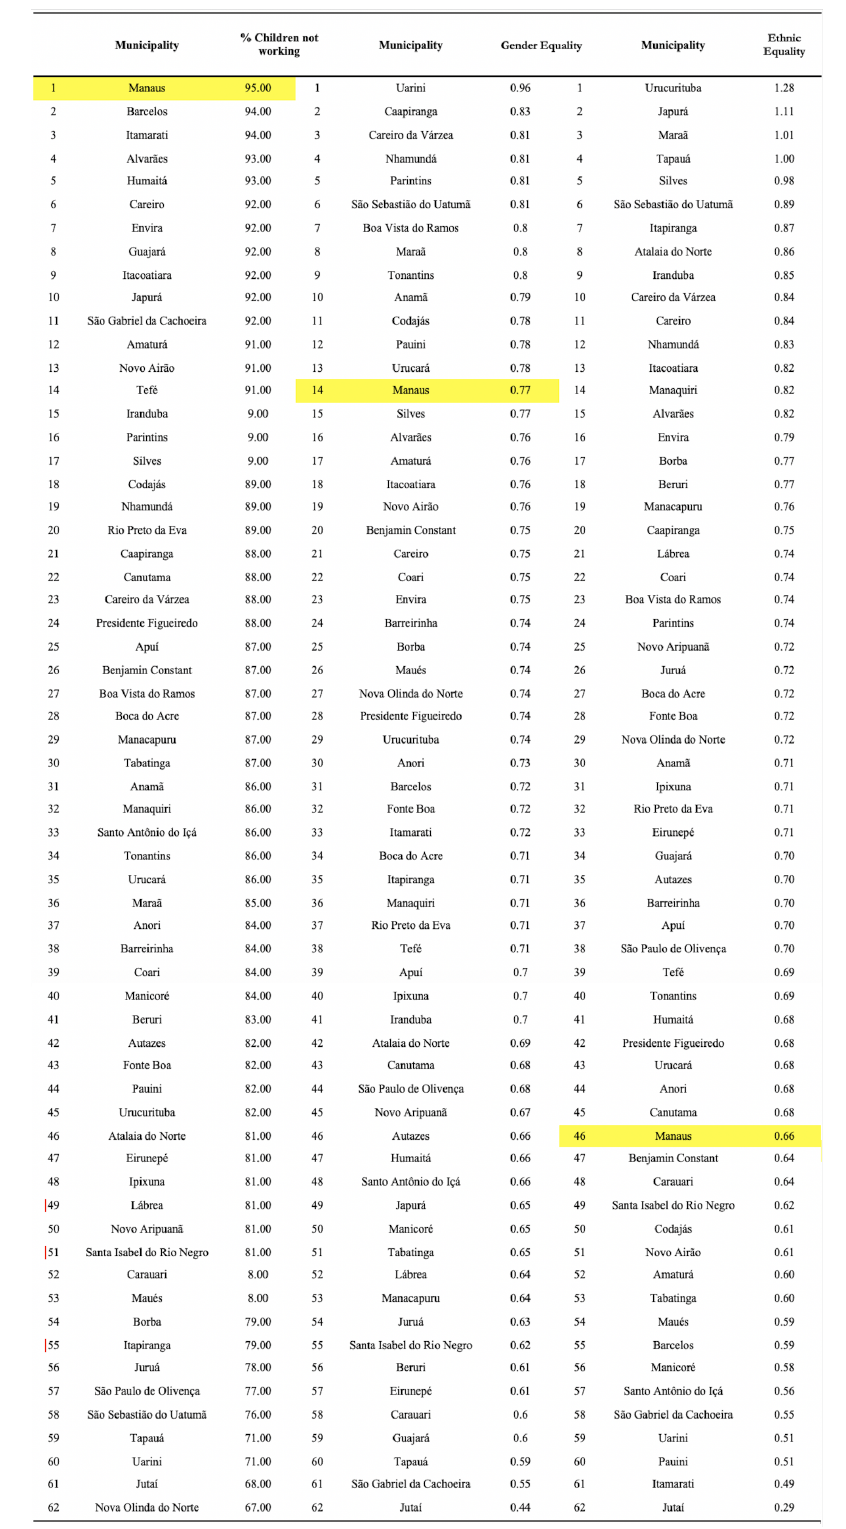
Table 8: Ranking Labor Standards of Amazonas